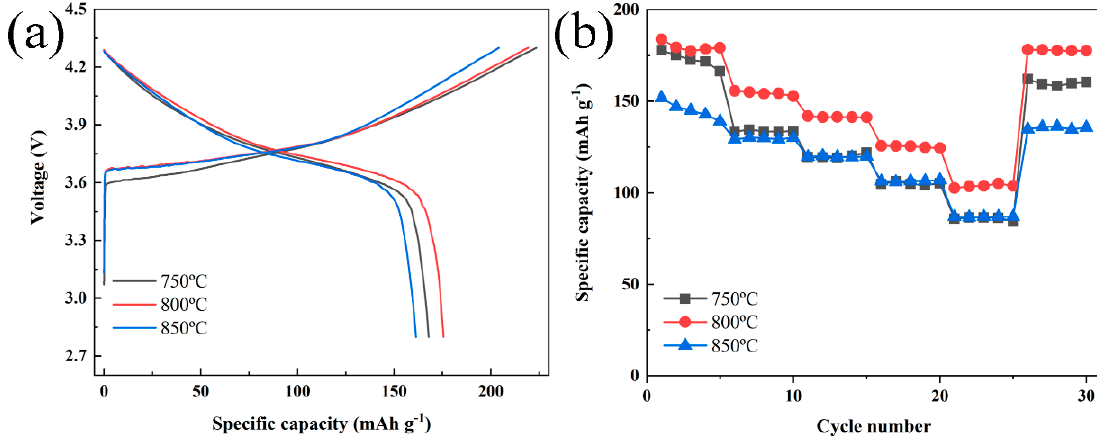
Figure 7. ( a ) The initial charge–discharge curves at 0.1 C, and ( b ) rate performance of NCM622 at different sintered tem-